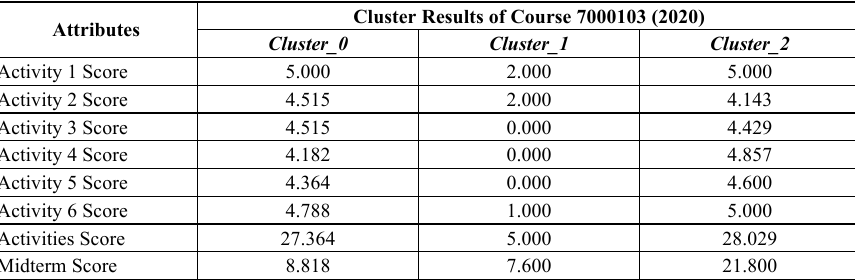
Table 4. Cluster results for course 7000103